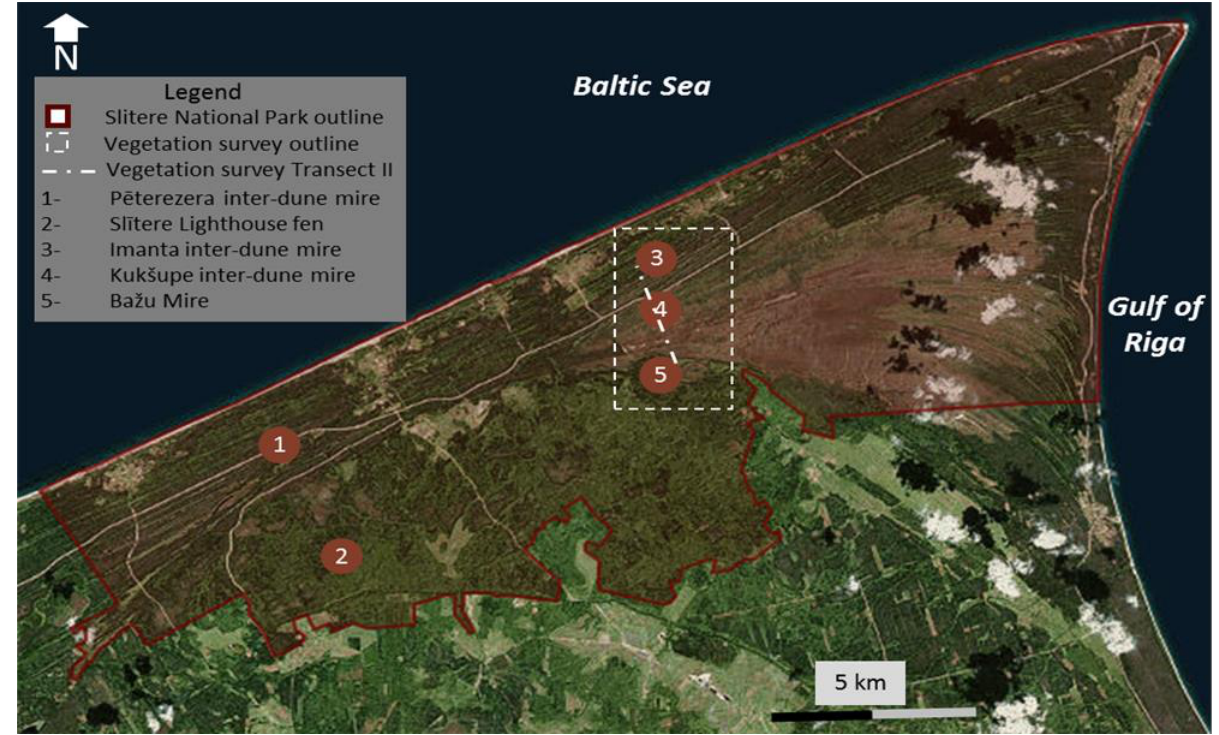
Figure 3. Distribution of mires in Slītere National Park. Study sites: 1 = Pēterezera inter-dune mire (PM); 2 = fen near Slītere Lighthouse (FEN); 3 = Imanta inter-dune mire (IM); 4 = Kukšupe inter-dune mire (KM); 5 = Bažu Mire